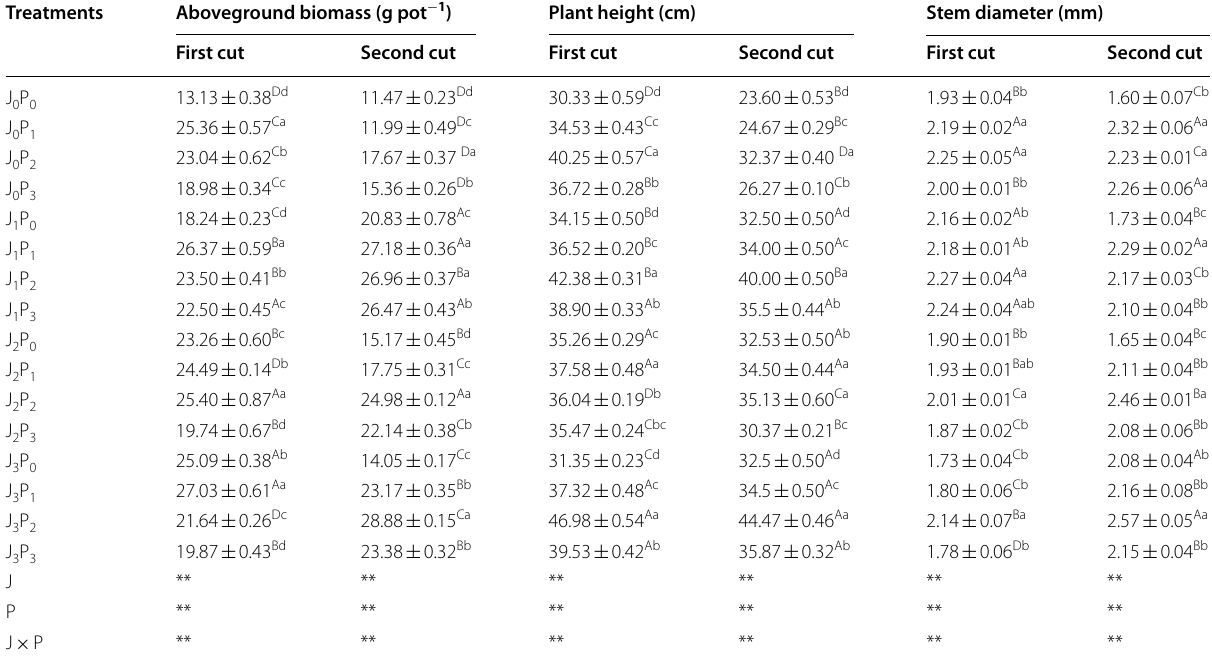
Different capital letters in the same column indicated significant difference in different bacteria treatments under the same phosphorus application conditions ( P < 0.05), differences small letters in the same column mean significant difference under the same bacteria application conditions ( P < 0.05). ** indicates significant difference extremely ( P <